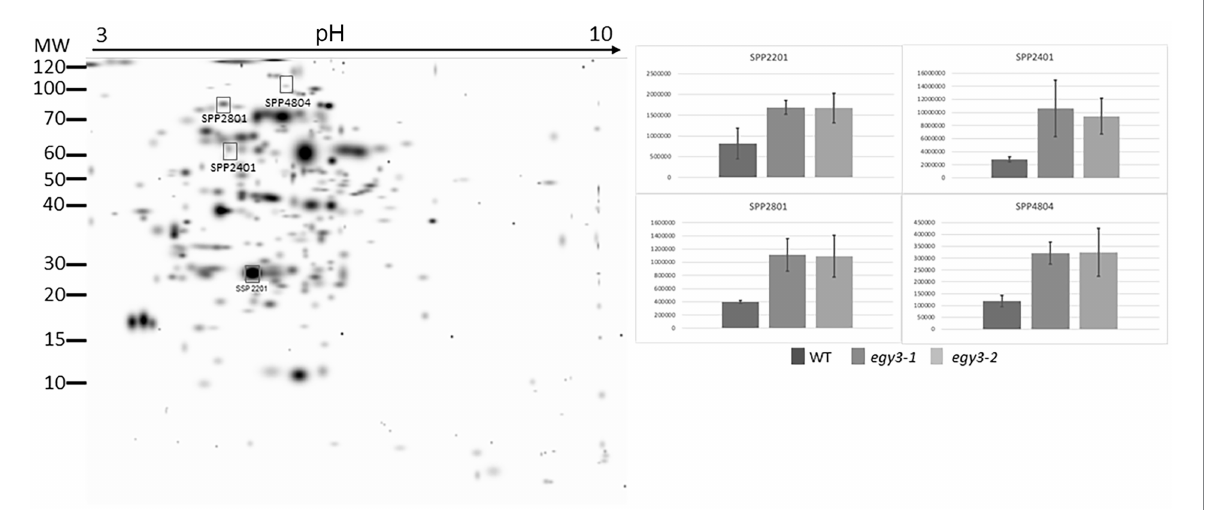
FIGURE 4 Two-dimensional electrophoresis gels of stroma proteins isolated from wild-type (WT) and egy3-1 and egy3-2 lines, exposed to 3 h of high light conditions. Proteins were separated using 2-D gel electrophoresis with IEF (pH 3–10) and detected with Coomassie Brilliant Blue staining. The image is digitally generated using the PDQuest Advanced 2-D Gel Analysis Software, (Bio-Rad, Hercules, United States) master gel, based on four electrophoretic separations made for two independent biological repetitions. The protein accumulation in the bar graphs was expressed in arbitrary